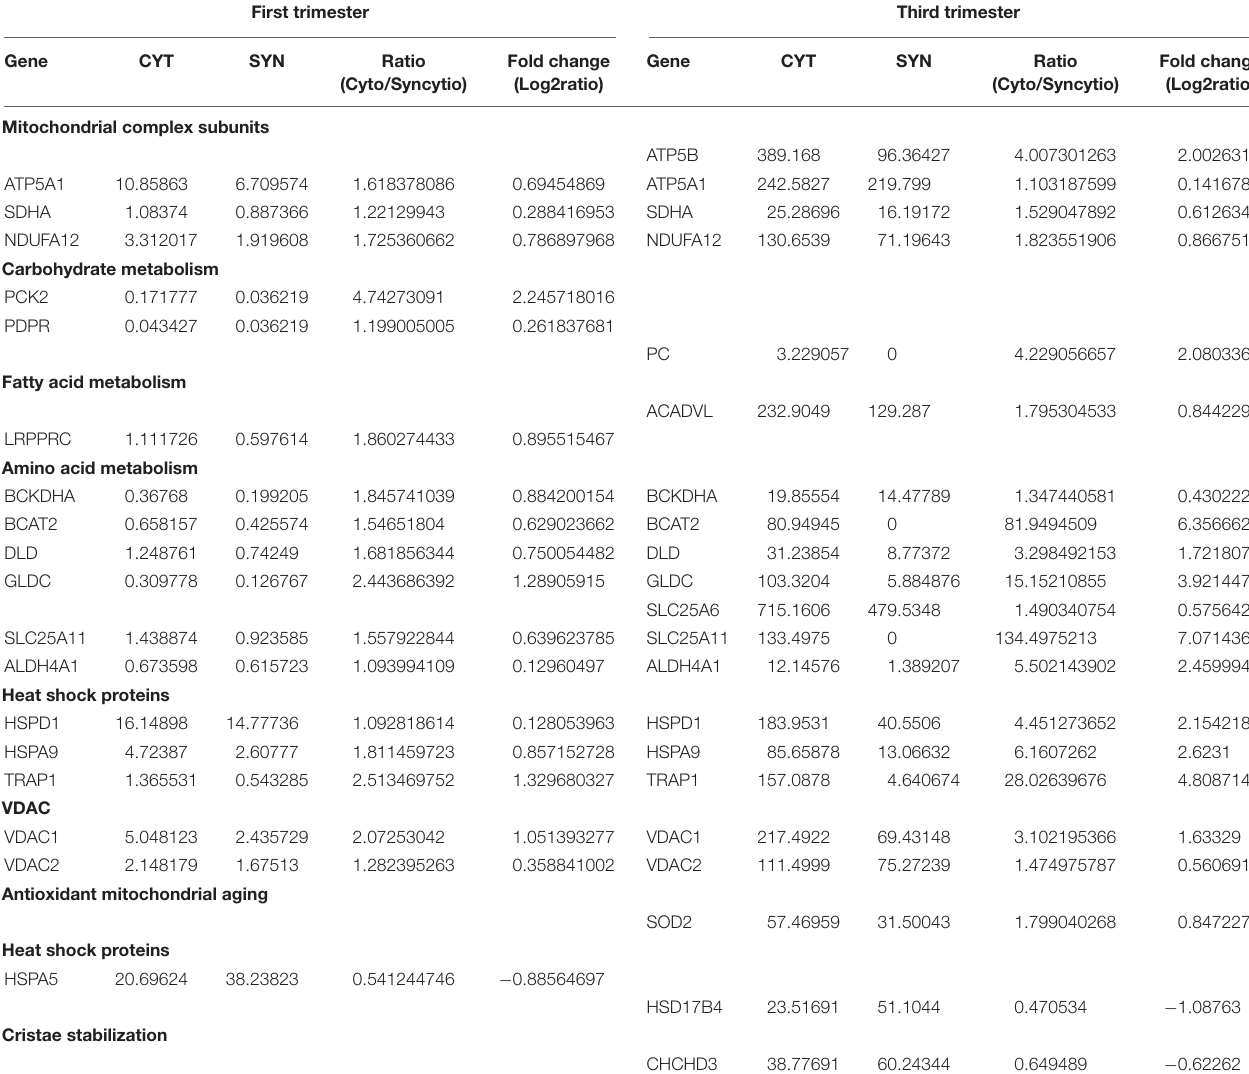
TABLE 3 | Data mining of single cell sequencing analysis of cytotrophoblast and syncytiotrophoblast from first and third trimester placentae which validates the experimental proteomic findings. Expressed as average transcripts per million